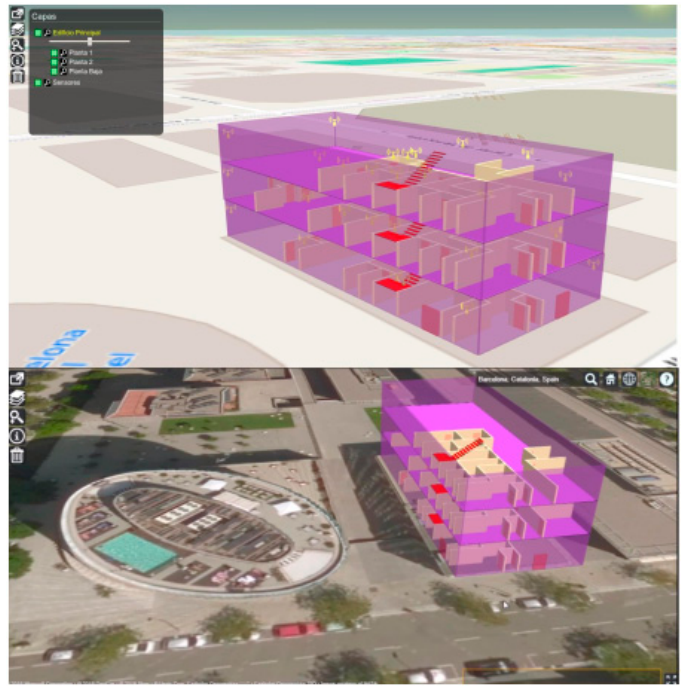
Figure 4. Web interface to visualize all data from the